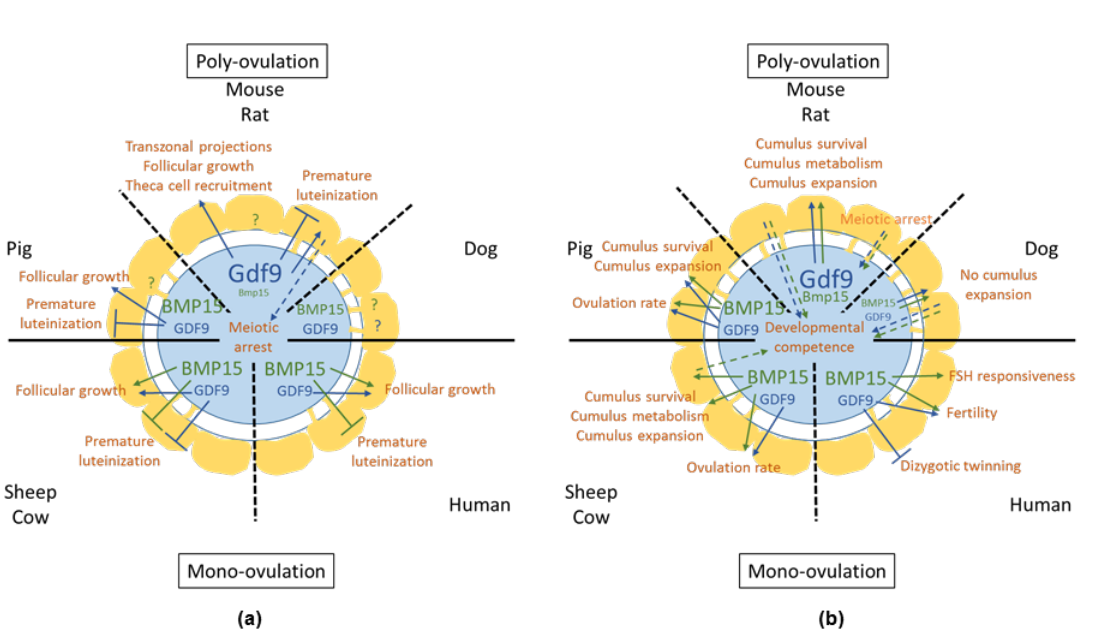
Figure 3. Comparison of the role of oocyte-derived BMP15 and GDF9 ( a ) in small growing follicles and ( b ) in large antral and preovulatory follicles. For GDF9 and BMP15 , letter size symbolizes the expression level. Solid lines and arrows indicate the effect of GDF9 (blue) and BMP15 (green) onto somatic cells (and onto follicular development and ovulation). Dotted lines and arrows indicate feedback actions of somatic cells onto the oocyte.